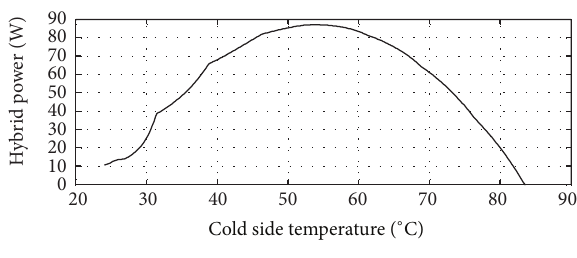
Figure 12: Total hybrid